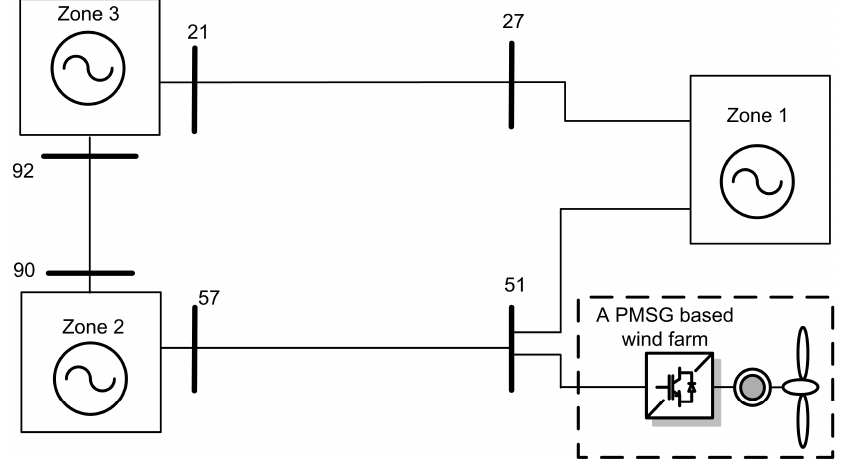
Figure 10. Schematic diagram of the WECC power